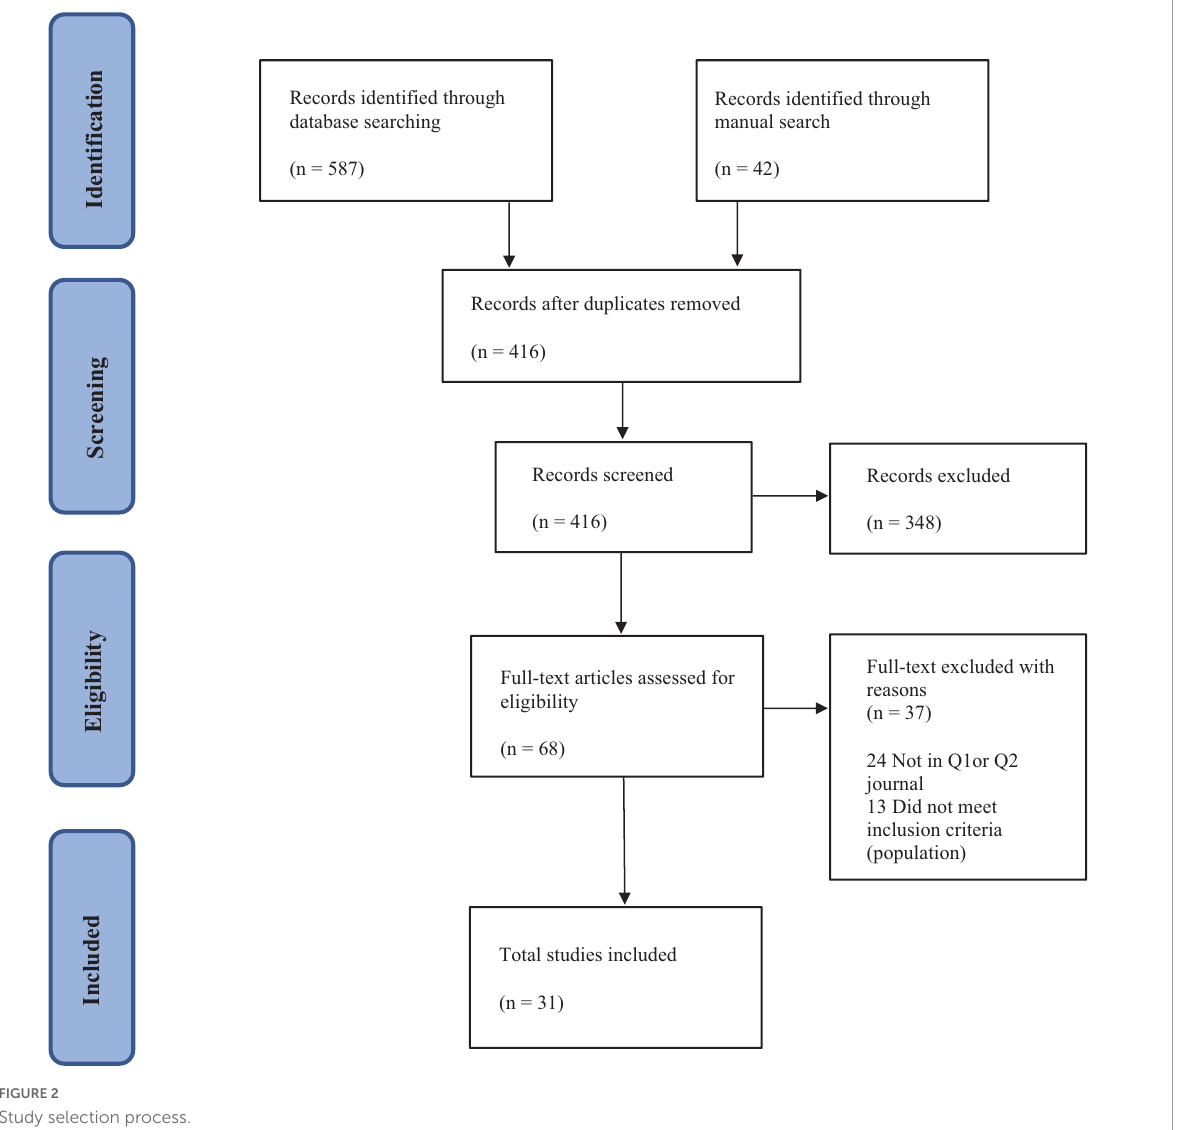
FIGURE2 Study selection